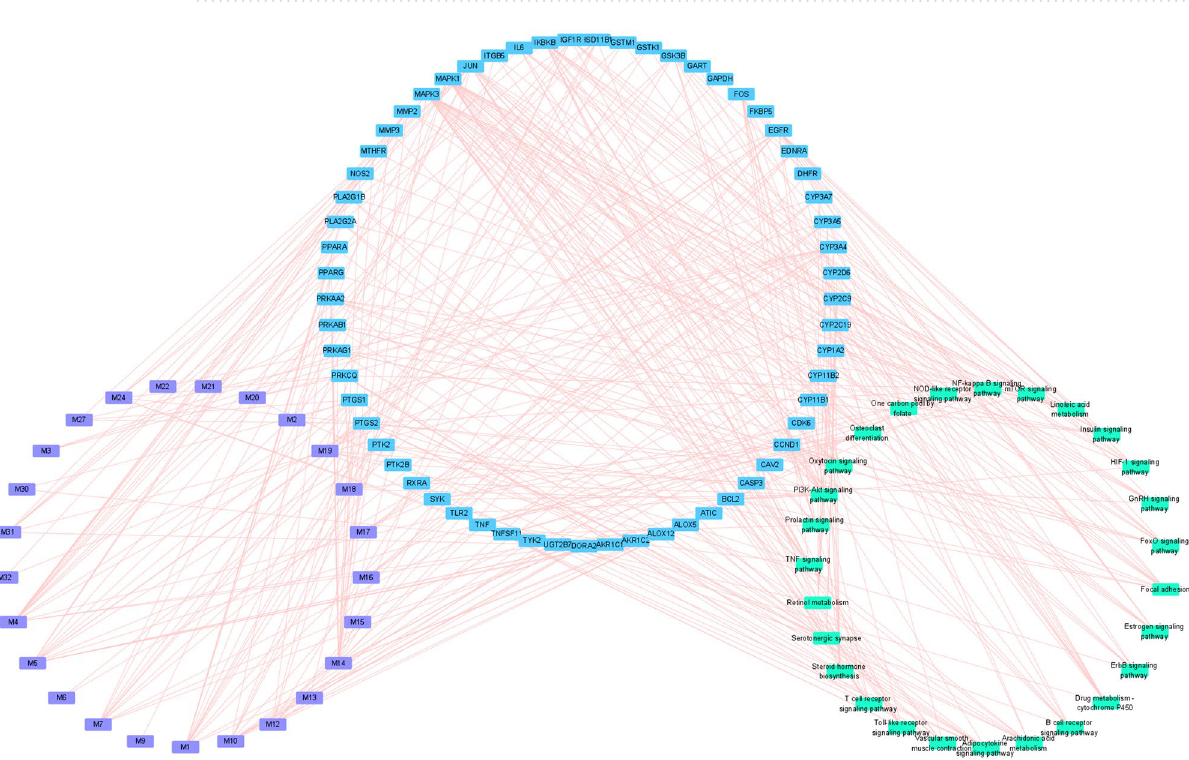
Figure 4. Gene ontology enrichment analysis showing the number of targets participating in biological process, cellular component, and molecular function.